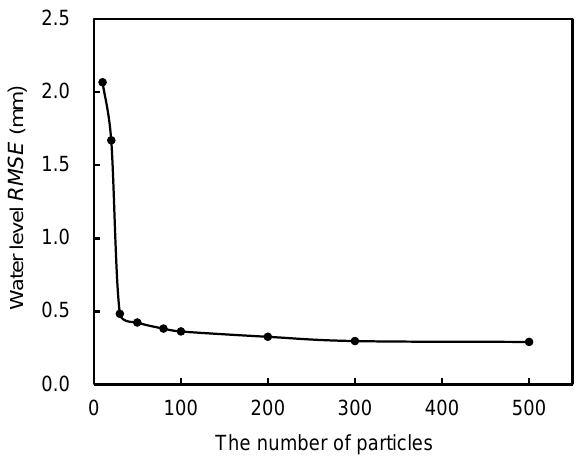
Figure 3. Relationship between the number of particles and the water level RMSE